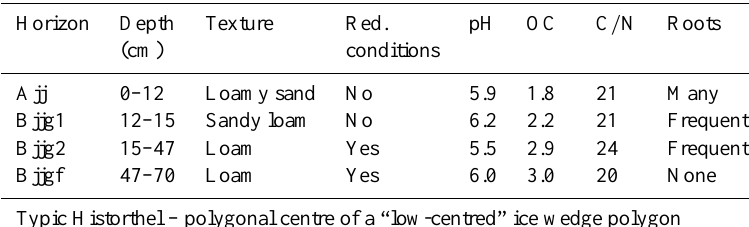
Table 2. Chemical properties of two exemplary soil profiles (see Fig. 11 and Fig. 13) with their horizons according to the US Soil Taxonomy (Soil Survey Staff, 2010), horizon depth, texture, hydromorphology, pH value, organic carbon content in weight percent, C / N ratio and rooting.